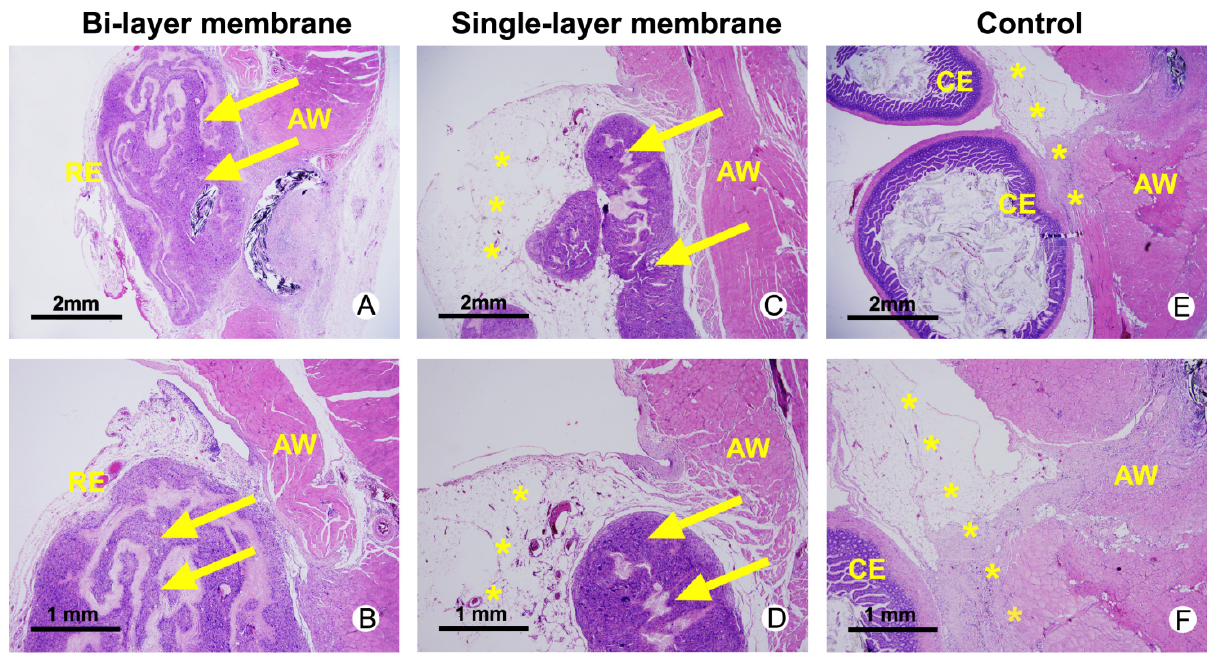
Figure 4. Hematoxylin and eosin (HE) staining of abdominal wall defects from bi-layer membrane treated ( A , B ), single-layer membrane treated ( C , D ) and untreated animals with severe adhesion ( * ) between the abdominal wall (AW) and the cecum (CE) surface. Remnants of the materials are highlighted with yellow arrows and located inside the re-epithelialized (RE) abdominal wall defect